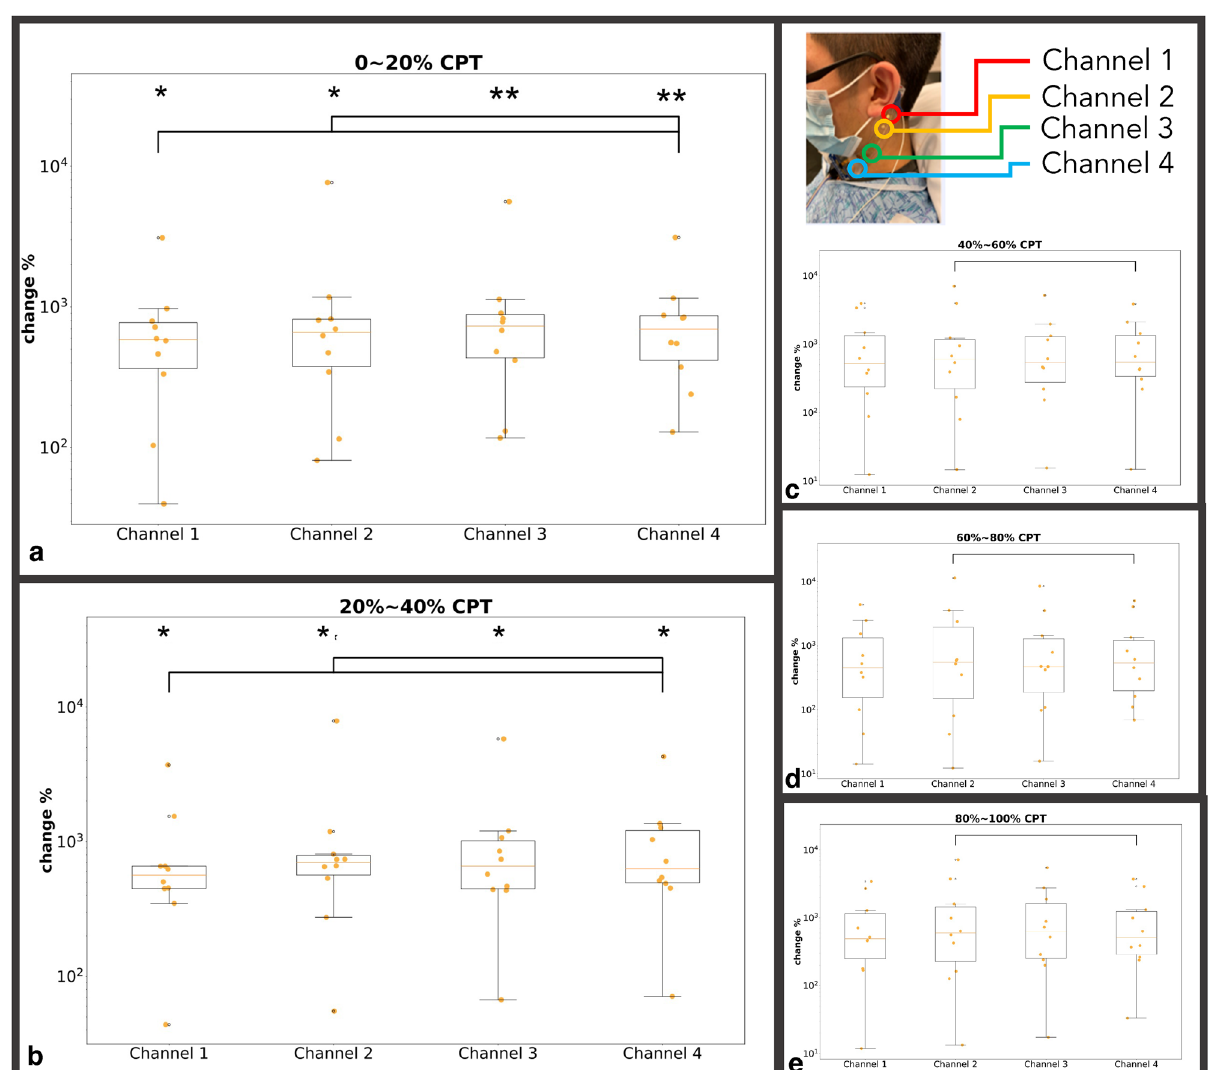
Figure 4. All subject channel activity across CPT indicated as % time intervals: ( a ) 0–20% of CPT; ( b ) 20–40% of CPT; ( c ) 40–60% of CPT; ( d ) 60–80% of CPT, and ( e ) 80–100% of CPT duration. Panel A: For the first interval of 0–20%, Channels #3 and #4 demonstrate highly significant increases in firing frequency (**p < 0.001), while Channels #1 and #2 also increased in firing frequency, but to a lesser extent (*p < 0.05) when compared to baseline. Channel #4 (lower carotid artery) demonstrated significantly greater (connected segment) firing than Channels #1 and #2 (p < 0.05). Panel ( b ) All channels remained at relatively increased activity (p < 0.05) when compared to baseline. An increase in firing in Channel #2 was observed when compared to Channel #4 (p < 0.05). Panels ( c – e ) All channels do not show increases in activity when compared to baseline. Channel 2 continued to demonstrate significantly greater firing than Channel 4 for the remaining CPT duration (p < 0.05). Channel #1 = overlying upper nodose ganglion; Channel #2 = overlying lower nodose ganglion and trigeminal auriculotemporal branch; Channel #3 = overlying upper carotid artery; Channel #4 = overlying lower carotid artery. X Axis: Channel 1–4; Y Axis: Percentage Increase in neural firing frequency with respect to baseline